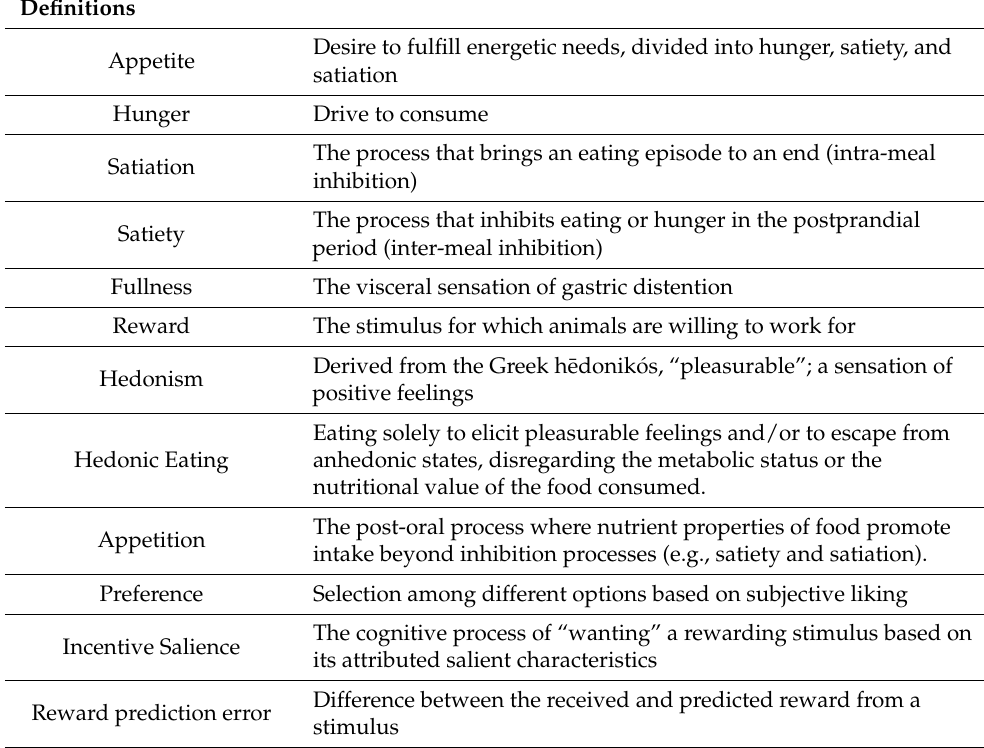
Table 1. Definitions in homeostatic and hedonic food intake